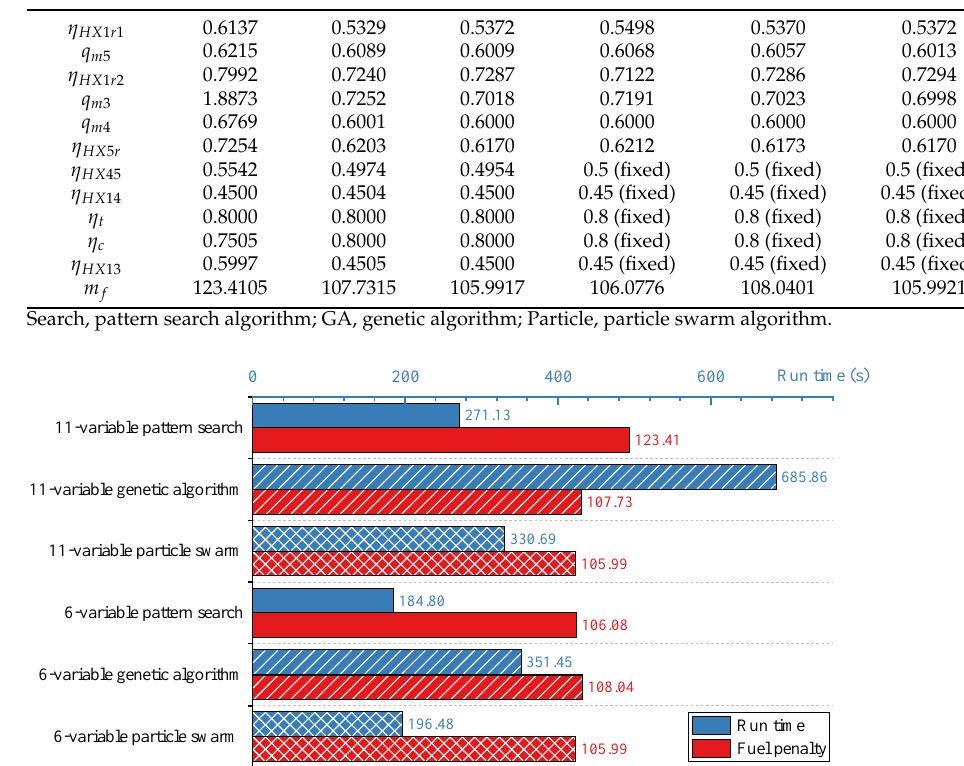
Table 4. Comparison of two optimization designs’ results of the integrated thermal management sys- tem. 11 Variables Variables